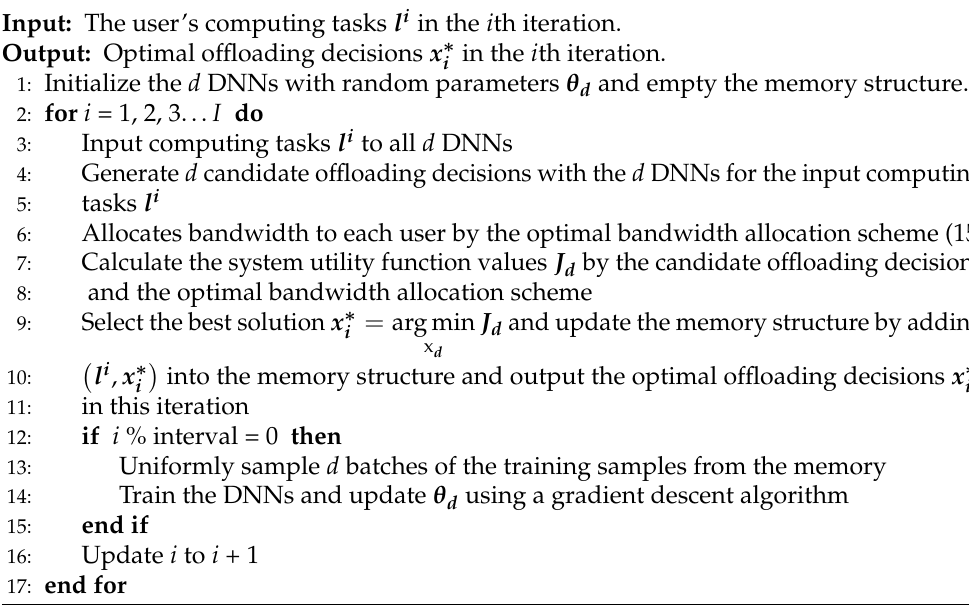
Algorithm 1 Proposed algorithm for joint optimization computing offloading and band- width allocation in LEO satellite edge